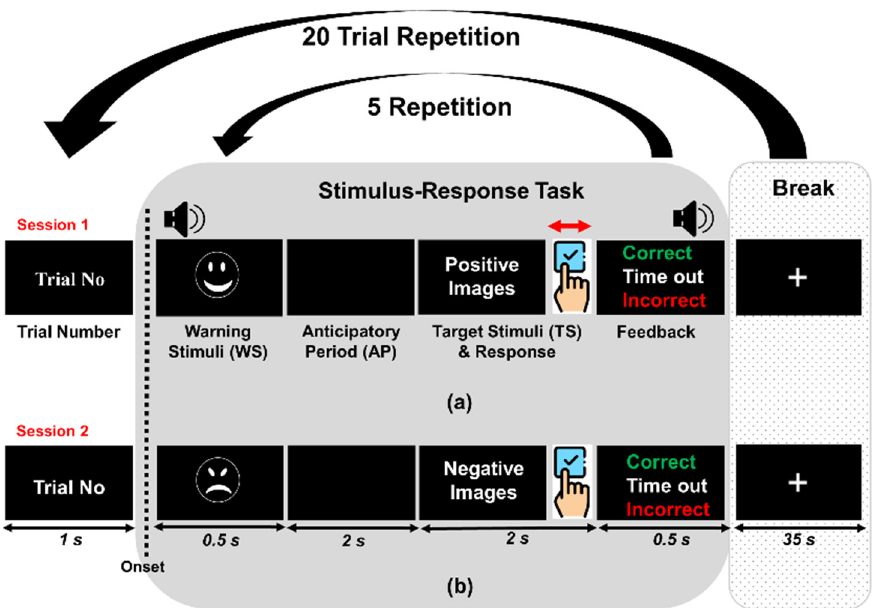
Figure 2. Experimental paradigm. Each participant performed two sessions: ( a ) Session 1 (a positive image ratio (30%) and a negative image ratio (70%)), and ( b ) Session 2 (a negative image ratio (30%) and a positive image ratio (70%)). This experiment compared the hemodynamic responses and behavioral results of each group depending on the ratio of emotional images. In each stage, a custom emotional stimuli-response task was presented for 25 s (i.e., 1 trial: 5 s × 5 repetitions) followed by 35 s rest. A total of 20 trials were conducted.